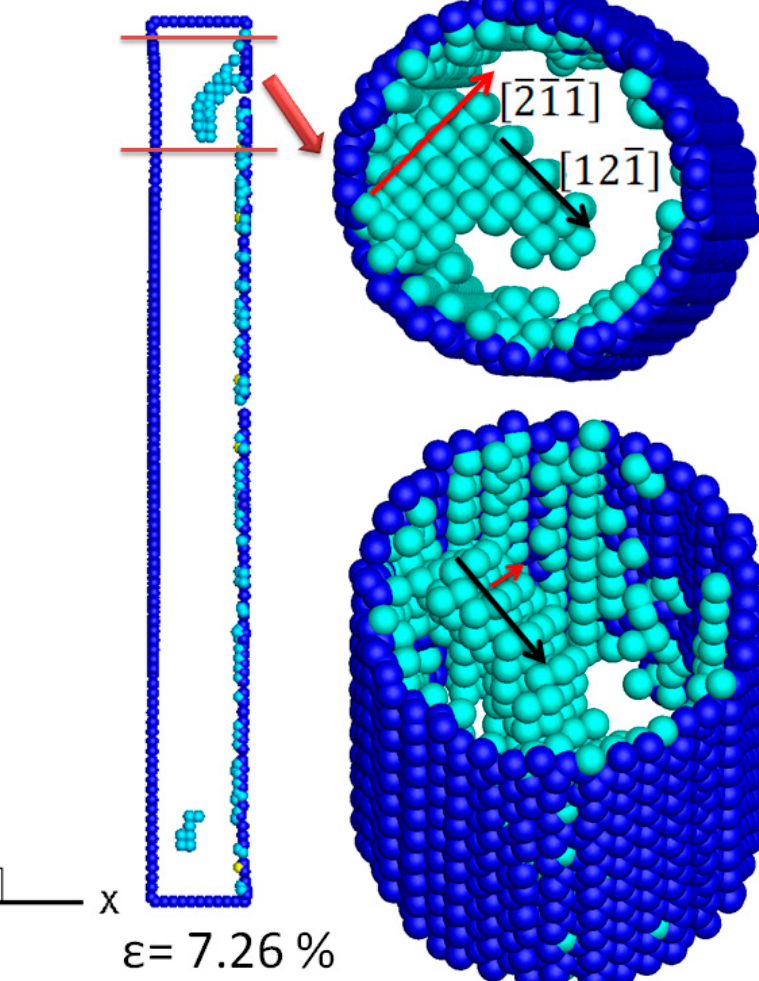
Figure 5. Slip directions of atoms (cyan) in (001) SiNW (The directions of [1 2 − 1]: black; and [2 − 1 − 1]: red).